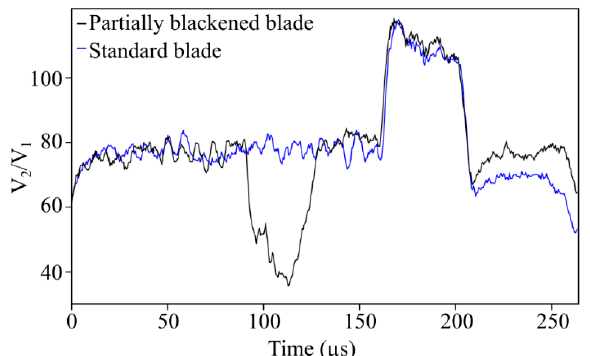
Figure 9. Comparison between a standard blade (blue curve) and a blade with an unexpected feature on it (black curve). In this case, the feature corresponds to a small blackened area on the long platform of the